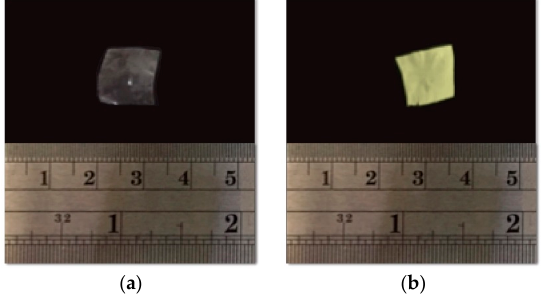
Figure 7. Photographs: ( a ) a small fragment of xerogel γ -CDPVAHMA3 without NFD; and ( b ) of small fragment of xerogel γ -CDPVAHMA3 with NFD. The formulations were lyophilized after the swelling process.